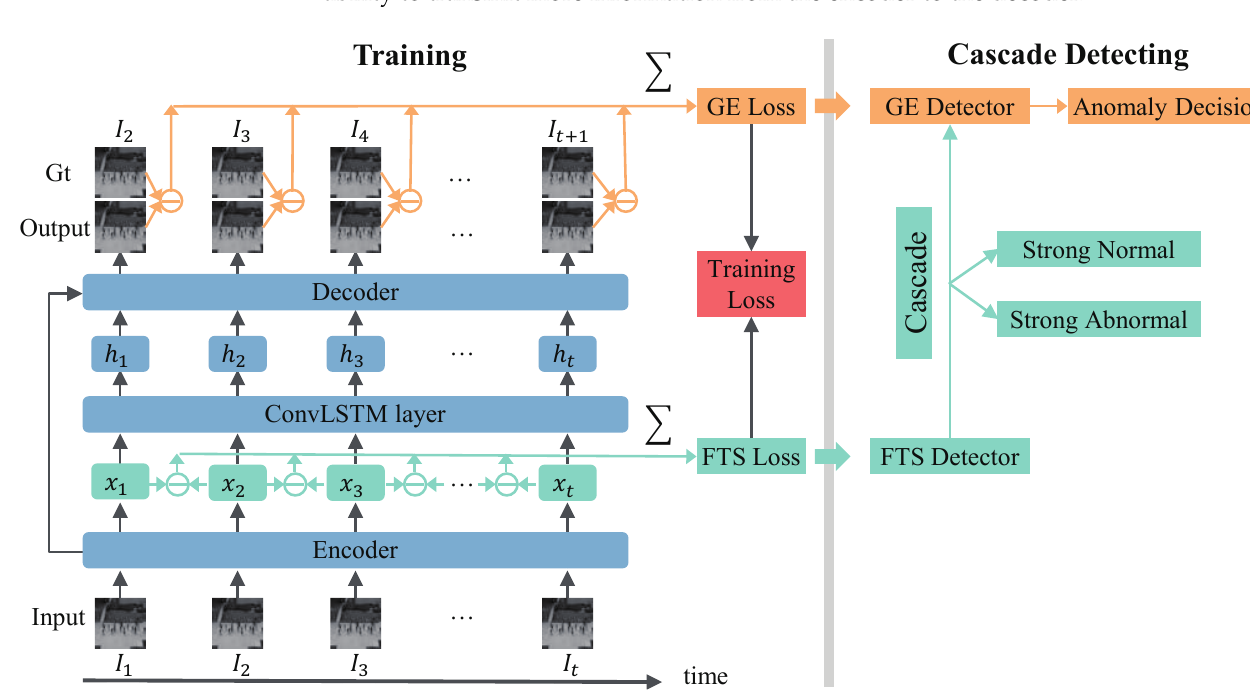
Figure 1. Pipeline of the proposed method. FTS-LSTM trains an LSTM-AE to predict future